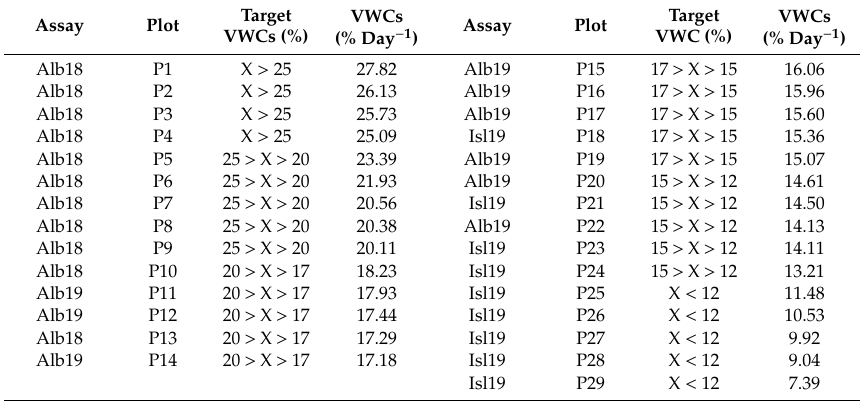
Table 2. Soil volumetric water (%) targets and actual content per day (VWCs day − 1 ) on each assay and